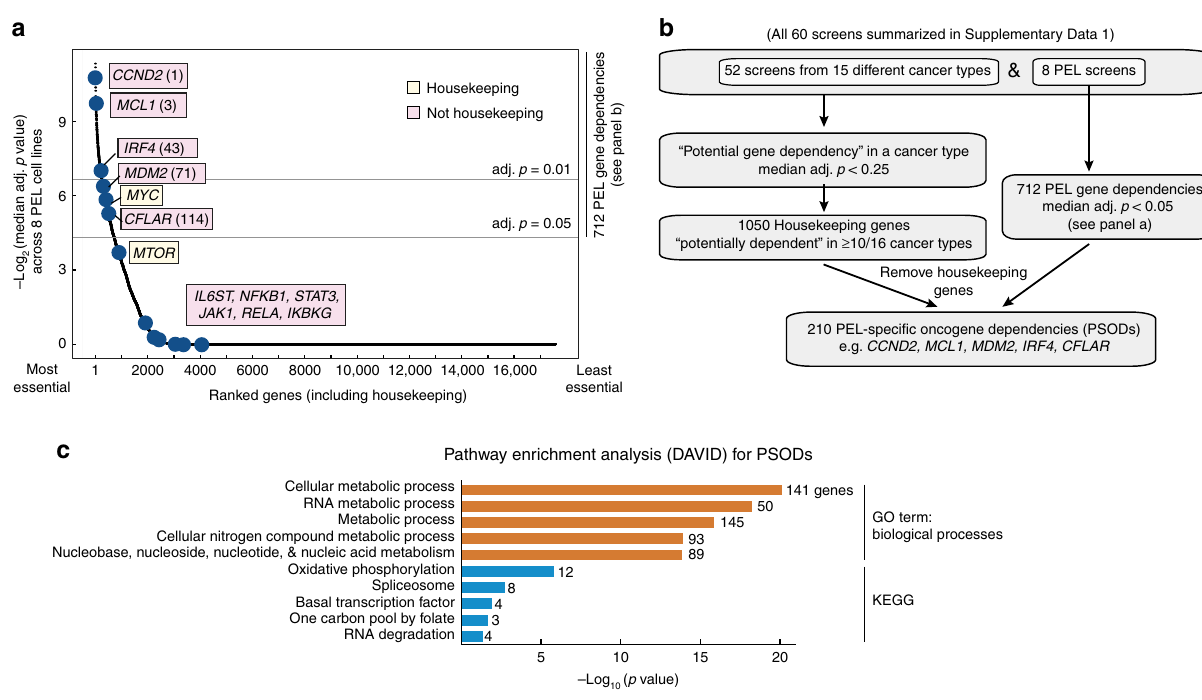
Fig. 2 Genetic dependencies of PEL cell lines. a Signi fi cance of dependency of all genes screened by Brunello library in 8 PEL cell lines. Genes are ranked using the median adj. p value scores (FDR). A large majority of genes, including those involved in NF- κ B (e.g., RELA , NFKB1 , and IKBKG ) and cytokine signaling (e.g., STAT3 and JAK1 ), score as dispensable in PEL cells. Genes in yellow are considered housekeeping genes, non-housekeeping genes are in pink. Ranks among PSODs are in parentheses. b Work fl ow and criteria for classifying “ housekeeping genes ” and “ PEL gene dependencies ” , based on CRISPR screens in this study and 52 publicly available screens. PEL gene dependencies that do not have housekeeping functions are further considered “ PEL-speci fi c oncogene dependencies ” (PSODs). c Pathway enrichment analysis of PSODs using DAVID for gene sets from GO (orange) or KEGG (blue). Number of genes included in each enriched pathway is indicated. Full results are in Supplementary Data lines (Supplementary Data 8). This approach de fi nes a core set of 712 “ PEL gene dependencies ” (using a median adj. p < 0.05 cutoff;